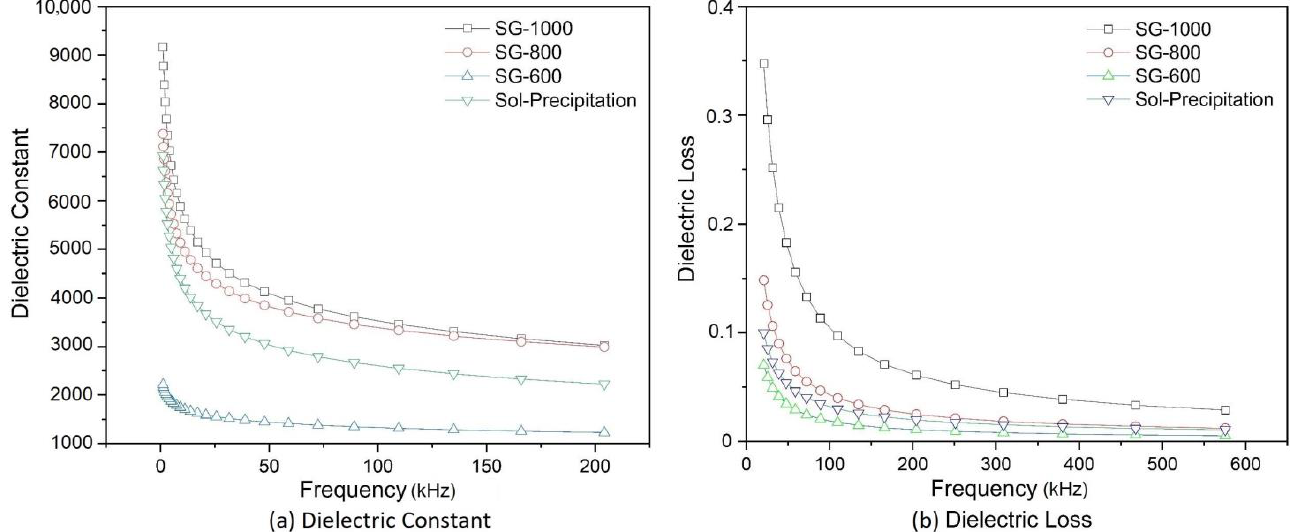
Figure 13. Variation in the ( a ) dielectric constant and ( b ) dielectric loss with the frequency at room temperature, with an applied voltage of 1 V.